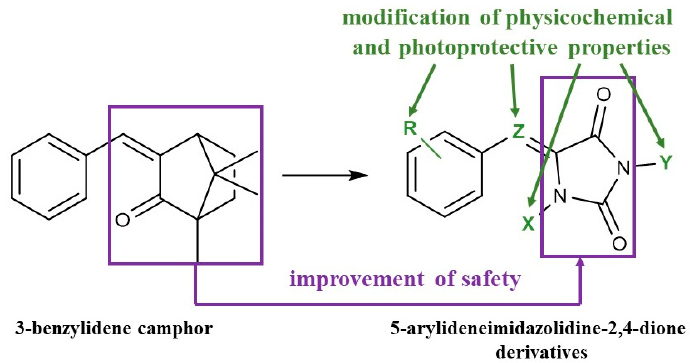
Figure 1. Design concept of the tested series: camphor was exchanged with hydantoin, while the benzylidene moiety remained unchanged or was extended.